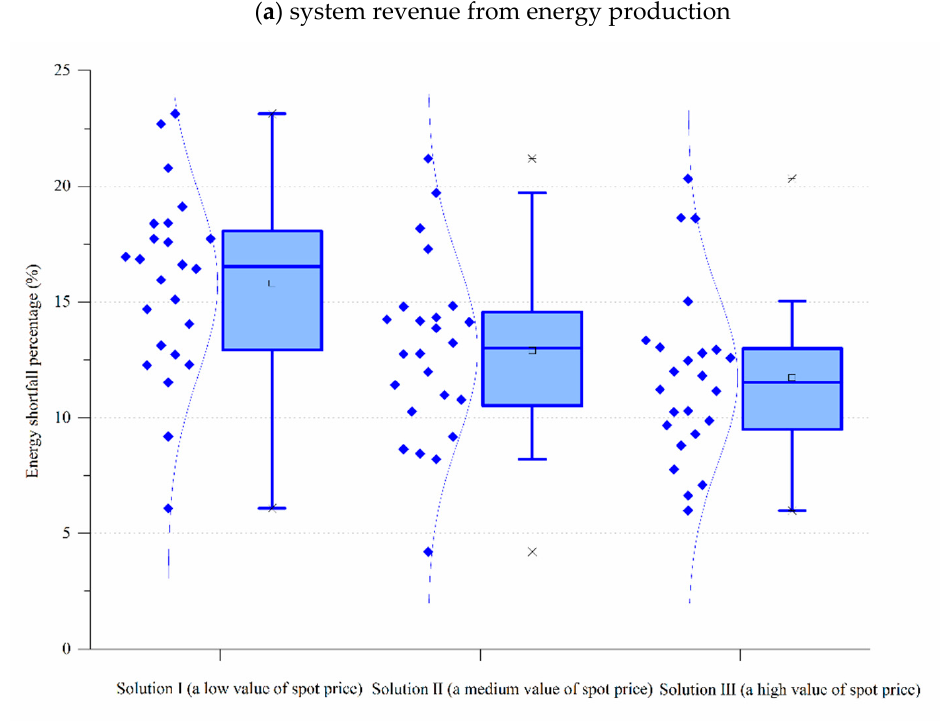
Figure 2. Optimal model results under different values of spot energy price.